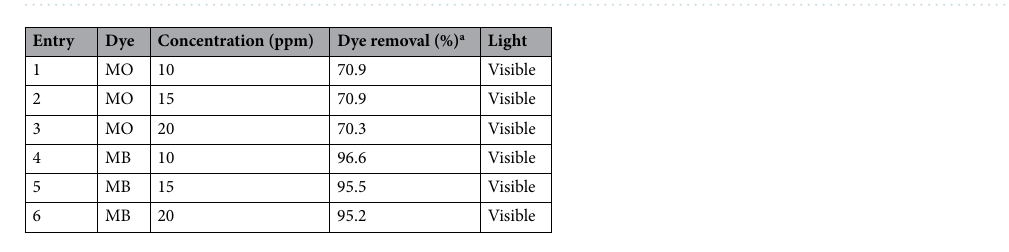
Table 3. Effect of dye’s concentration on photocatalytic decolorization. a Optimal catalyst (Fe 3 O 4 @BNPs-ZnS- CdS with ZnS/CdS molar ratio: 0.75/ 0.25).